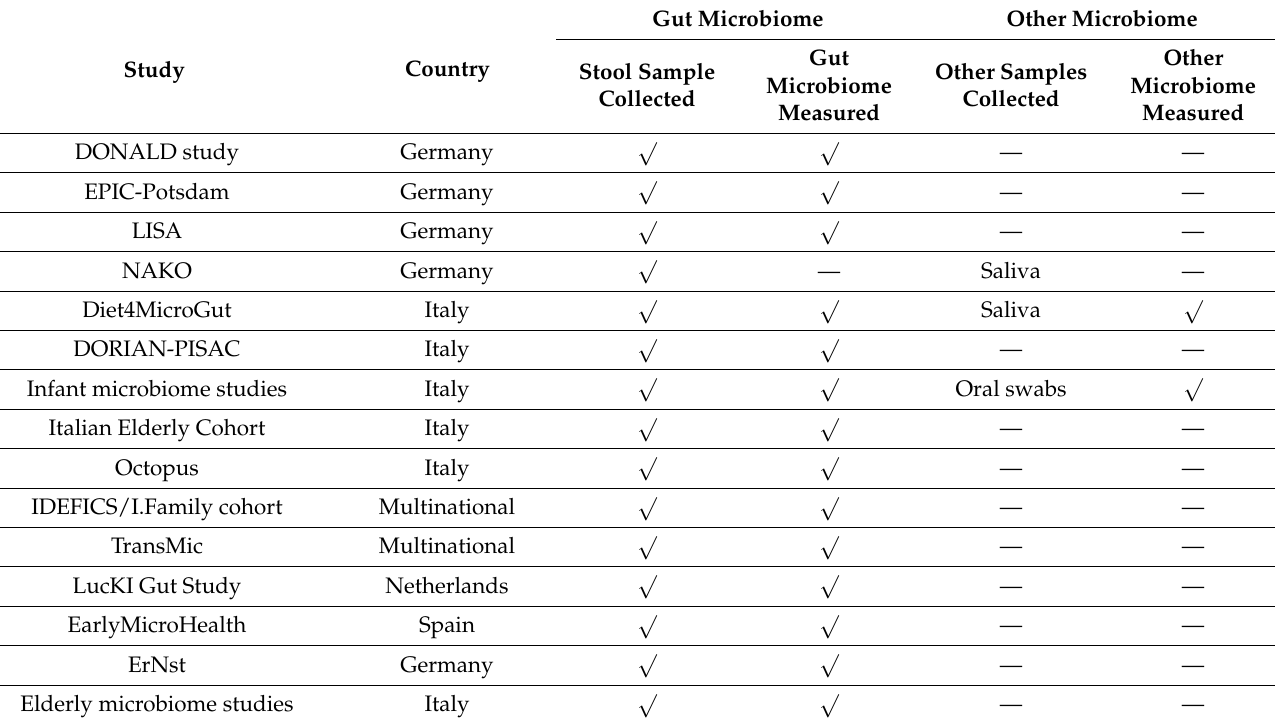
Table 3. Microbiome data available in the observational studies participating in the KP-INTIMIC